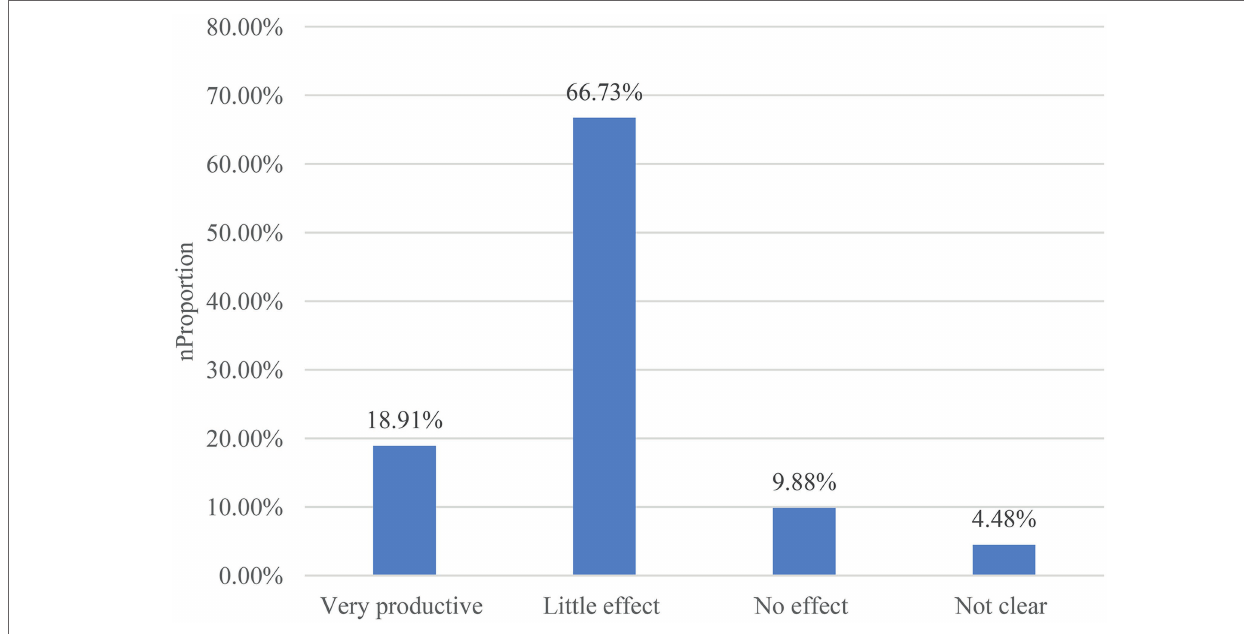
FIGURE 7 | The effect of community mental health education.